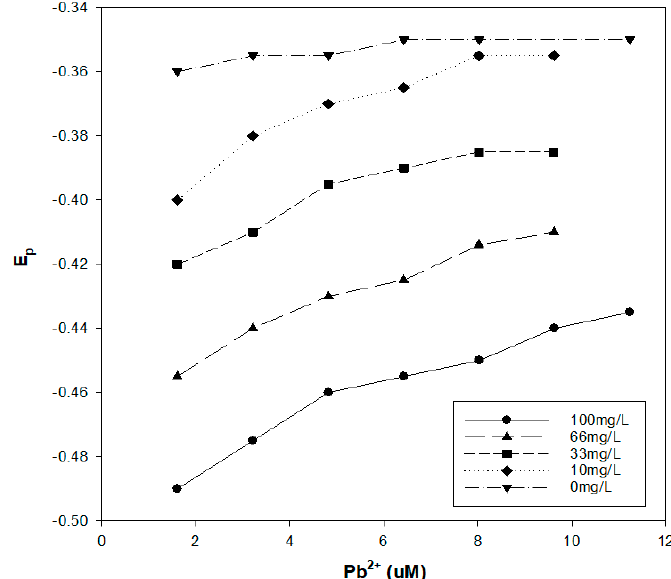
Figure 7. DPP results for Pb 2+ at pH 8 in the presence of TeraVita leonardite humic acid. The E p value shifts toward a more negative voltage with an increase in the humic acid concentration.